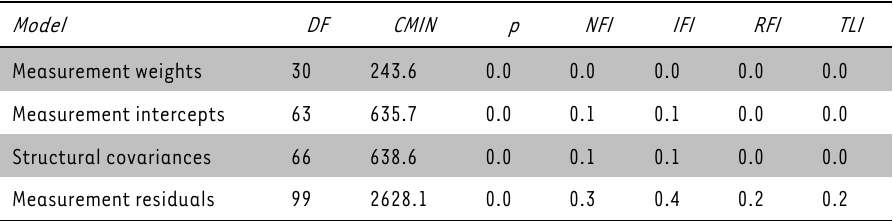
TABLE 2: Estimation results for general model Model DF CMIN p